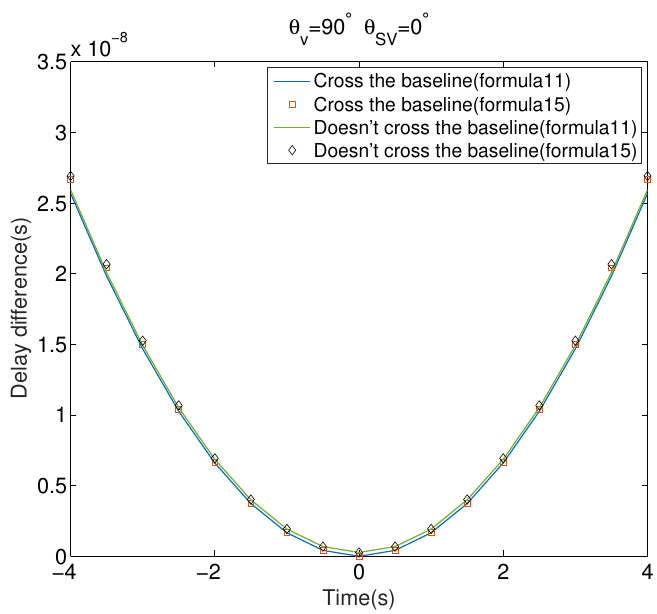
Figure 9. Different delay when the target does not cross the